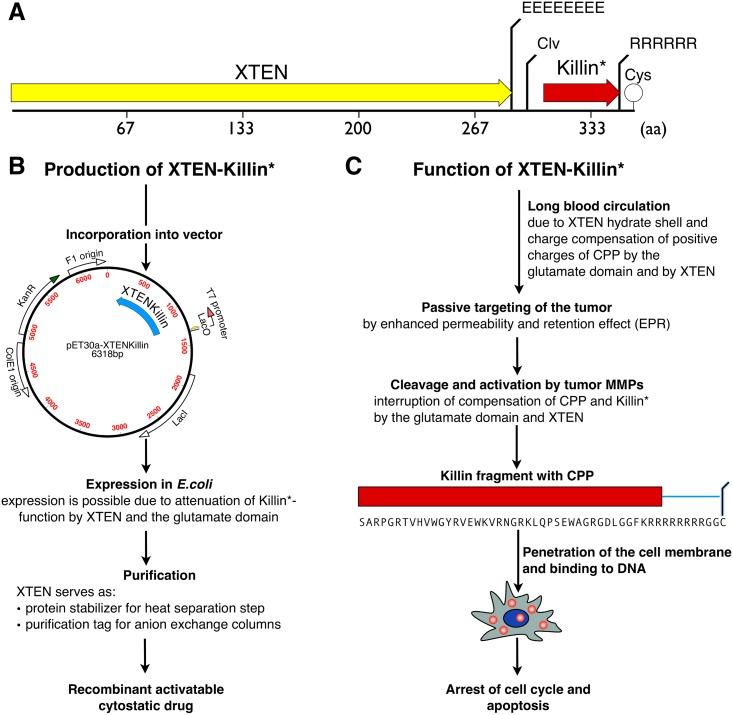
Construction of the recombinant cytostatic/cytotoxic protein XTEN-Killin.Schematic representation of the DNA/protein sequence of XTEN-Killin (A), the procedure for production (B), and a summary of its intended functions (C).